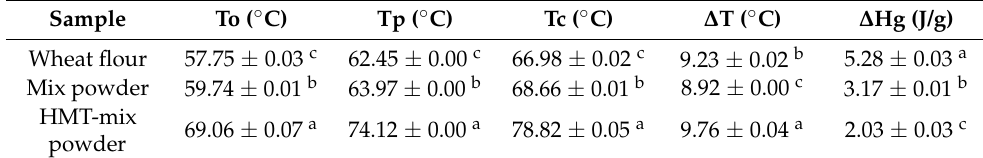
Figure 2. DSC curve of wheat flour, mix powder and HMT-mix powder. Table 3. Thermal properties of wheat flour, mix powder and HMT-mix